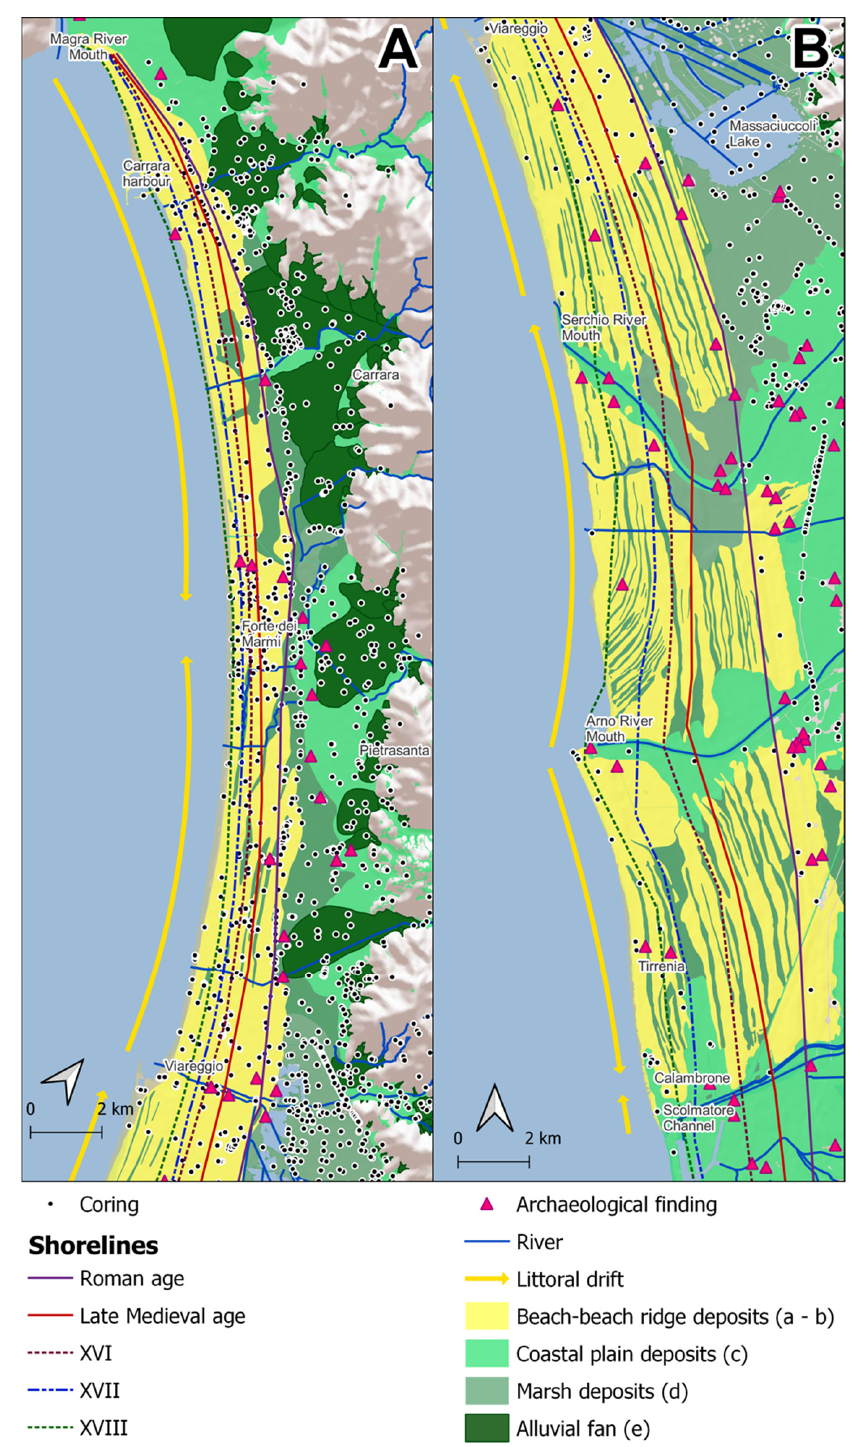
Figure 2. Geomorphological map of the study area showing the shoreline evolution since the Roman age. ( A ) Zoom-in of the sector between the Magra River mouth and the Port of Viareggio; ( B ) zoom-in of the sector between the Port of Viareggio and the Scolmatore Channel mouth.